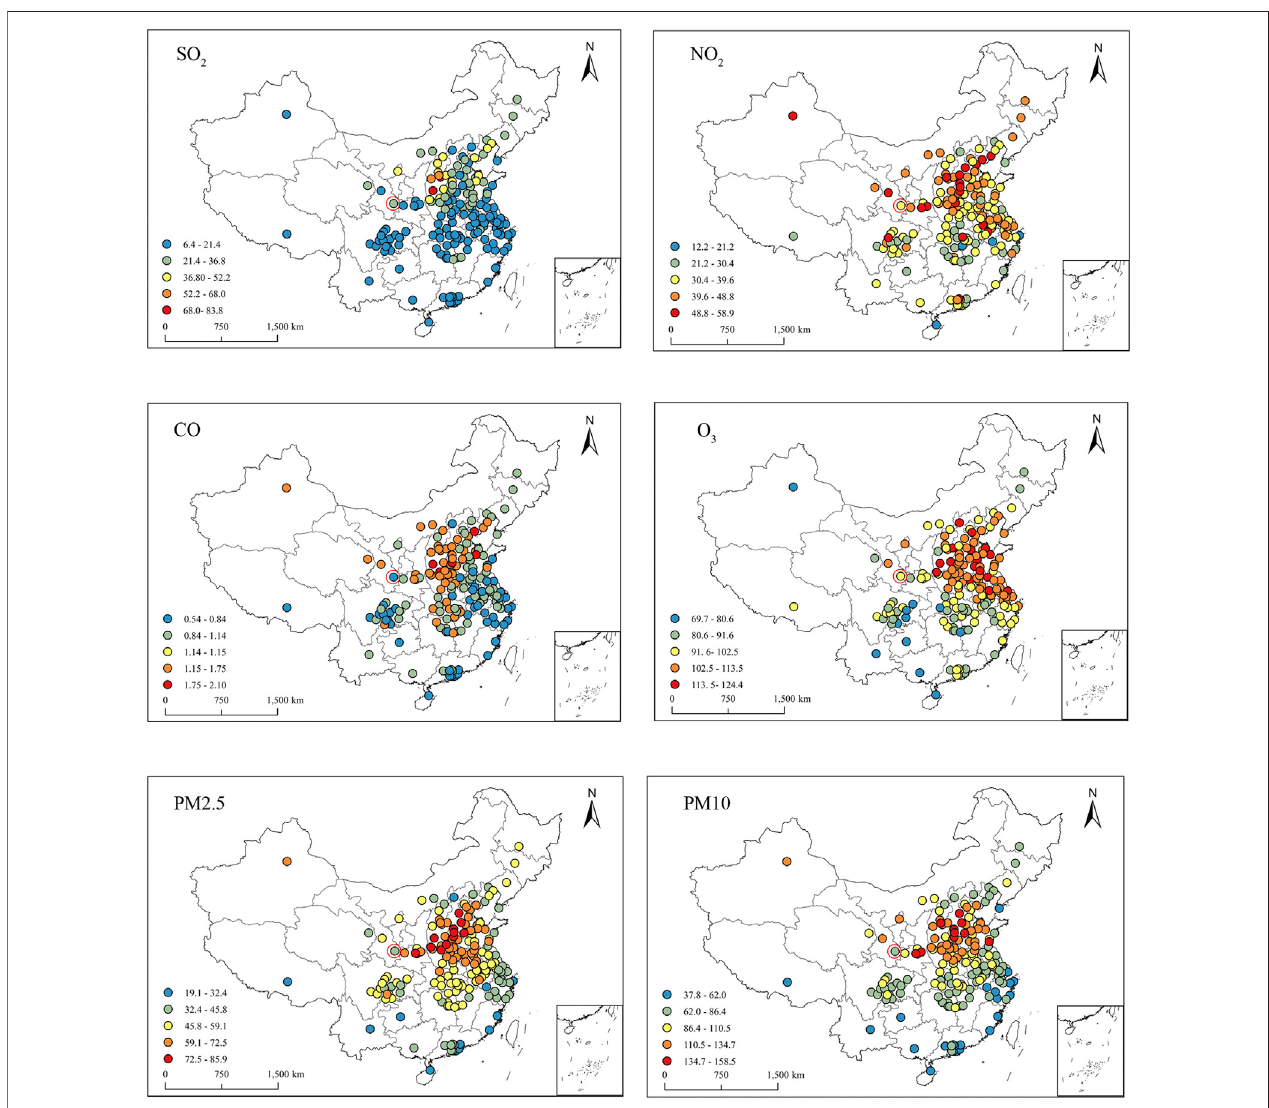
FIGURE 4 | Comparison of annual mean concentrations of six air pollutants for 168 major cities in 2017 ( μ g m − 3 , except CO mg m -3 ). The red circle indicates Tianshui. (a) SO 2 . (b) NO 2 . (c) CO. (d) O 3 . (e) PM 2.5 . (f) PM 10